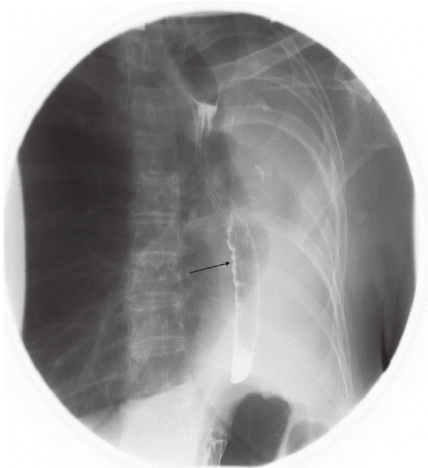
Figure 3: Anteroposterior spot image on double contrast esophagram demonstrates a leftward deviated esophagus that was appropriately distensible and without fixed narrowing. Expected primary stripping waves were present, and there was no delay in transit of oral contrast through the esophagus. Nonspecific tertiary waves were noted in the distal esophagus (black arrow) but is commonly seen in older patients with